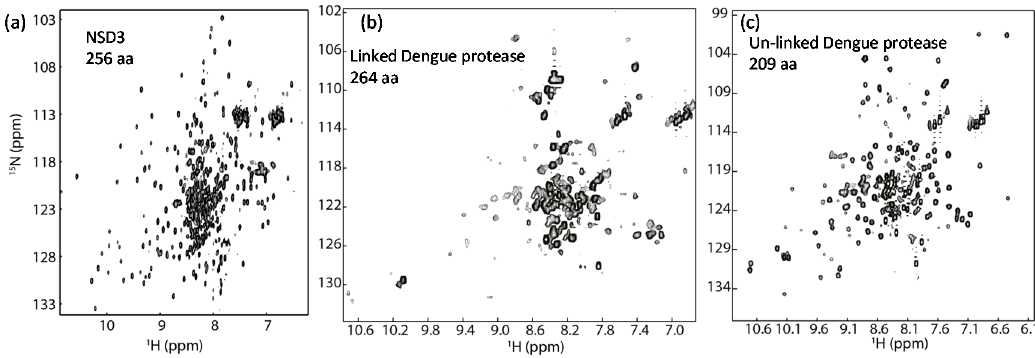
Figure 3. 1 H- 15 N-HSQC spectra of different proteins. ( a ) 1 H- 15 N-TROSY spectrum of the SET domain of human NSD3; ( b ) 1 H- 15 N-HSQC spectrum of Dengue virus protease. This is a linked protease construct which may contain both open and closed conformations. The construct exhibits crowded cross peaks in the spectrum; ( c ) 1 H- 15 N-HSQC of unlinked Dengue virus protease. Removal of the artificial linker in the construct used in ( b ) can result in a protease complex with dispersed cross peaks in the spectrum. The figures are obtained from reference [125] with slight modifications.